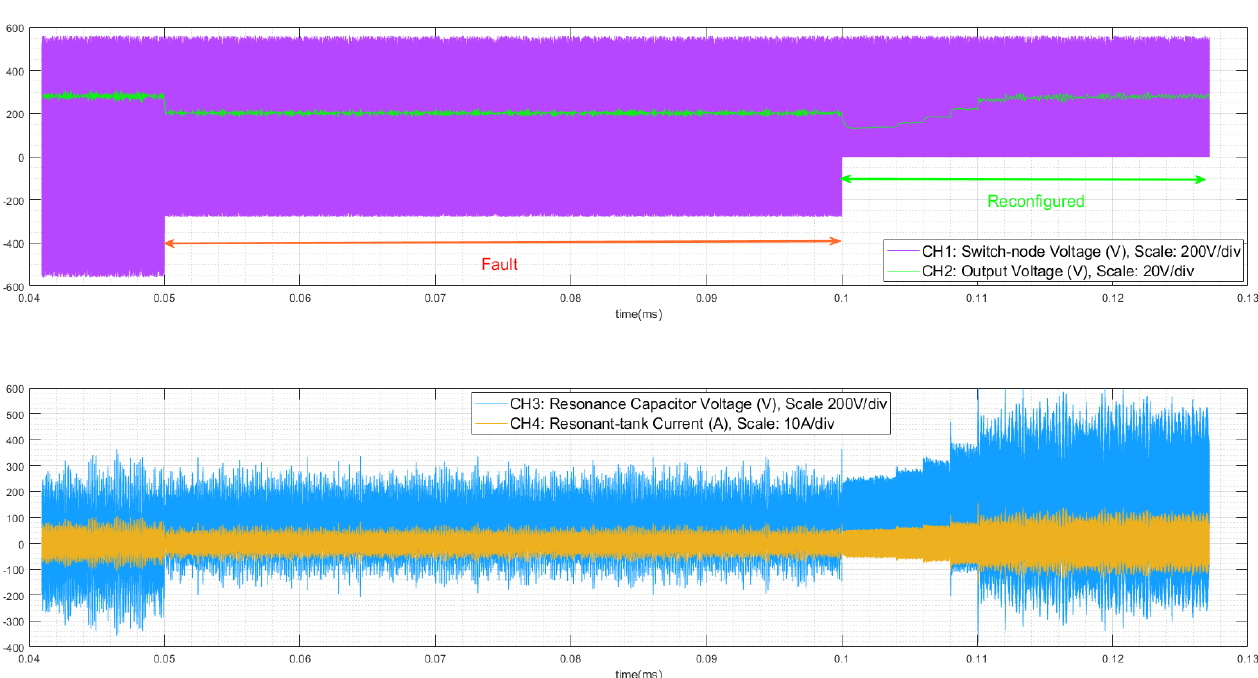
Figure 17. Transition of the transformer primary side switch node voltage, output voltage, resonant capacitor voltage, and inductor current, from fault–free to under–fault